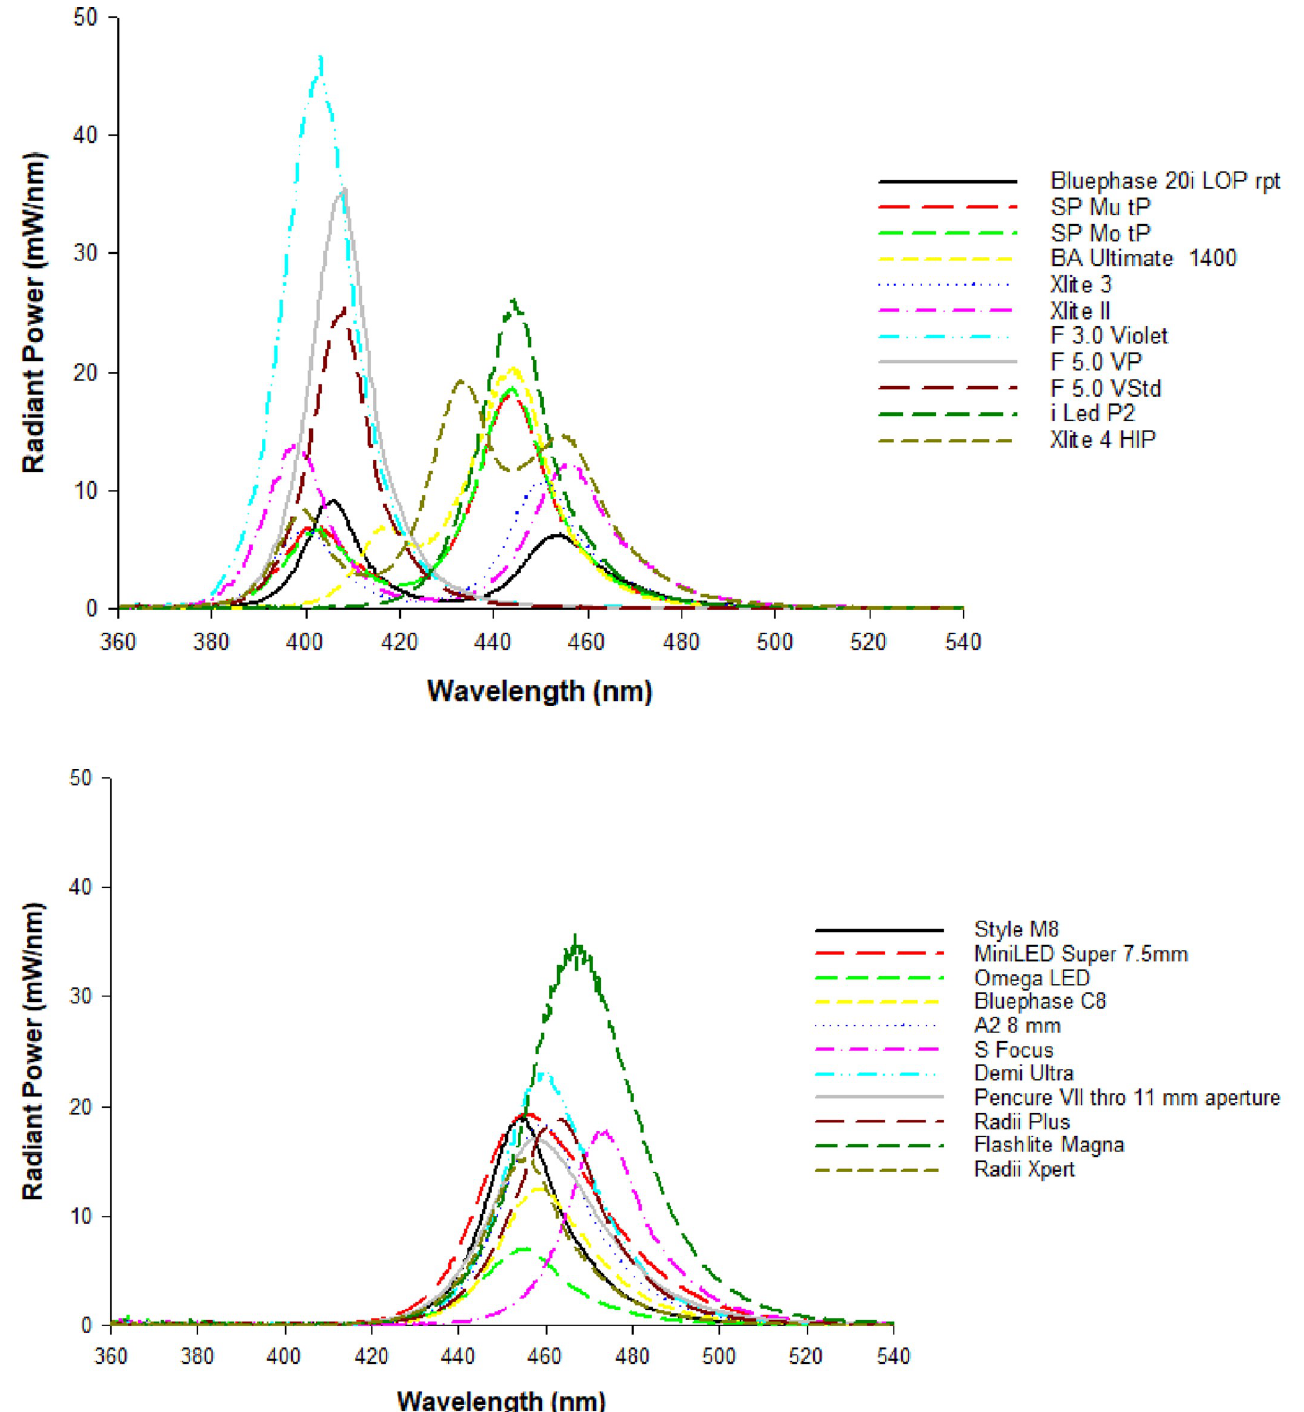
Fig 5. Radiant power of the LCUs, that delivered a) greater than 60% of their power output below 450 nm and b) greater than 65% of output above 450 nm.